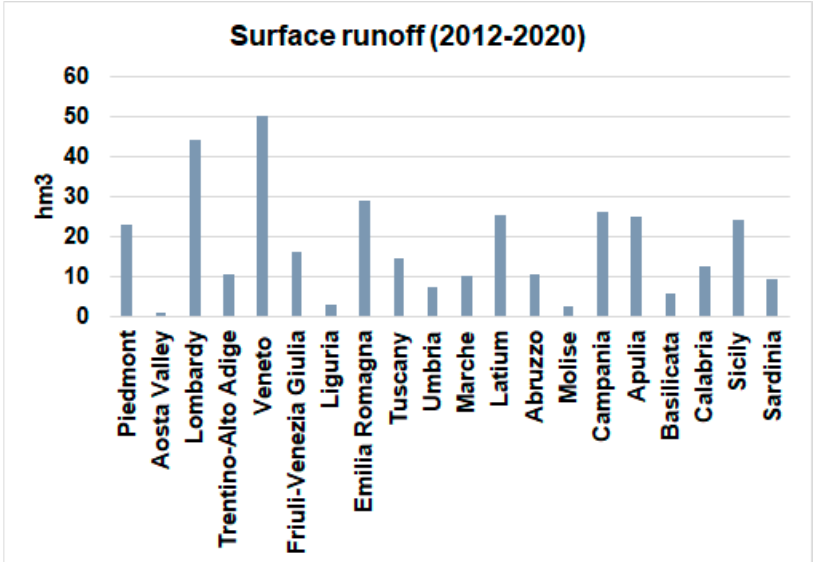
Figure 9. Surface runoff variations due to land consumption in the period 2012–2020 at the regional level.